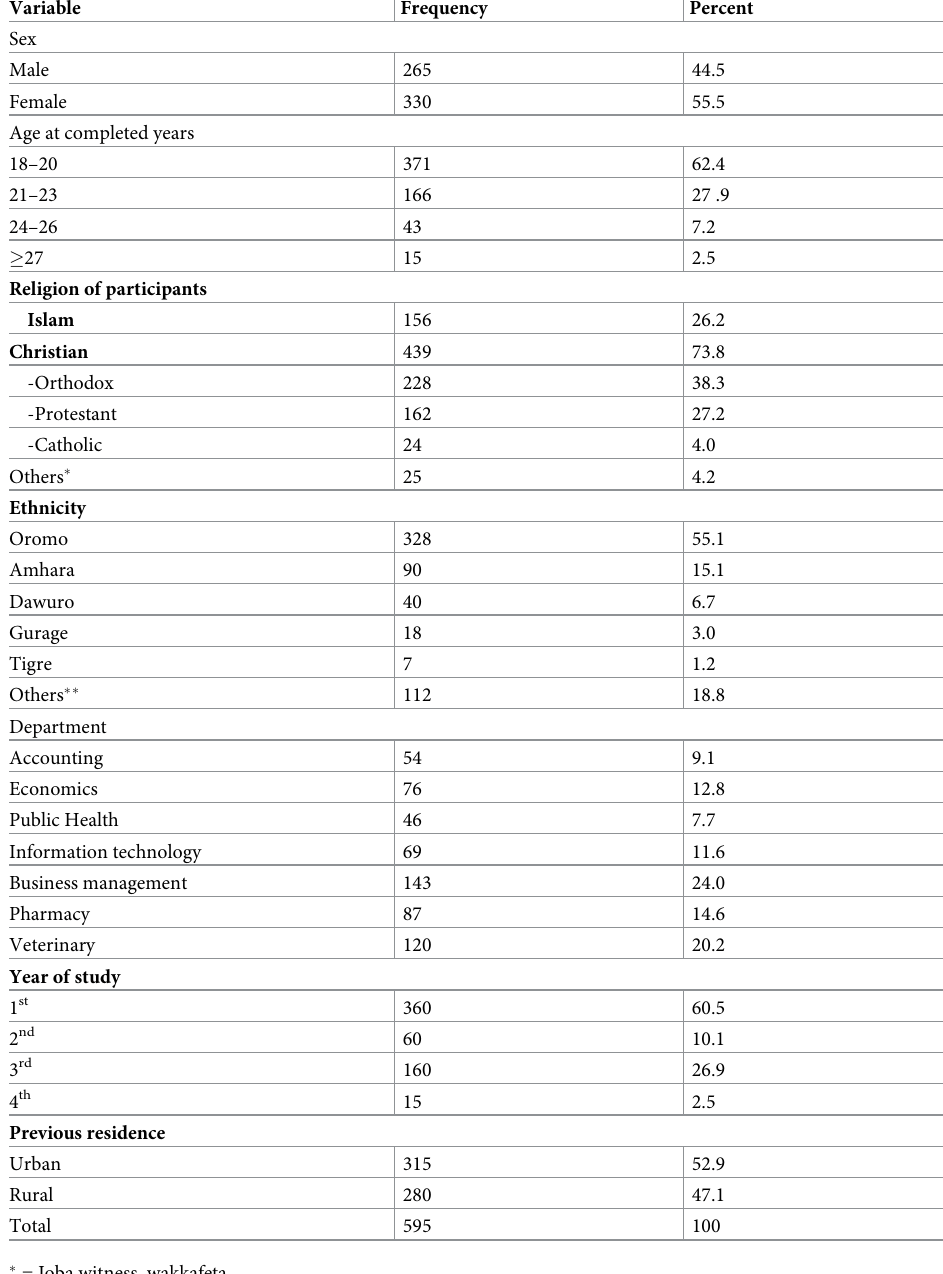
Table 1. Socio-demographic characteristics of respondents 2019 (n =